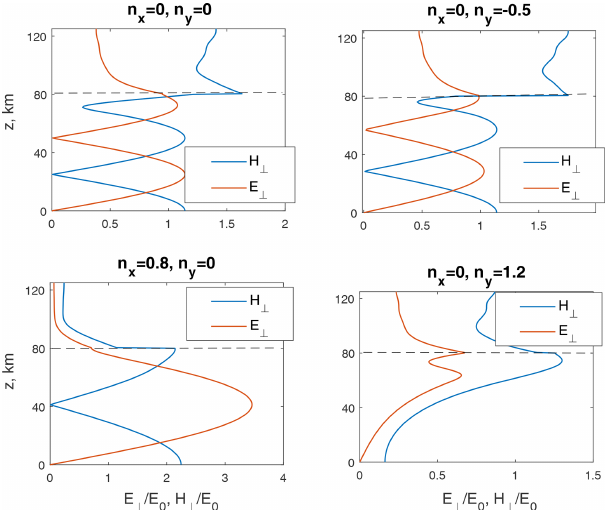
Figure 4. Source currents and field space distributions: (a) space distributions of source currents, (b) the electric field at z = 125km, (c) the horizontal magnetic field at z = 0, and (d) the polarization